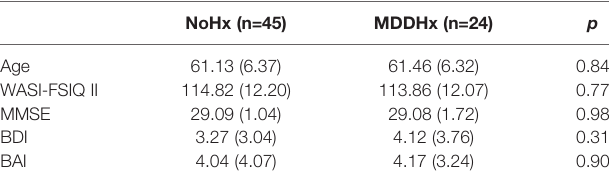
TABLE 2 | Demographics and screening.